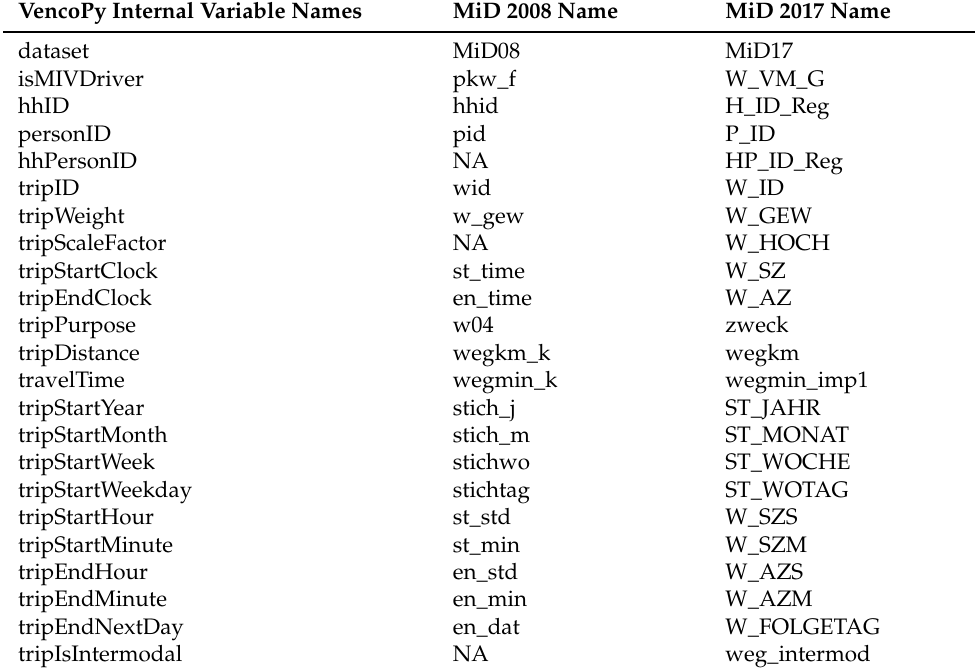
Table A1. Required trip variables from raw mobility travel surveys as a minimum requirement to serve as input to VencoPy. Shown are the VencoPy internal namings as well as the variable namings of the surveys MiD08 and MiD17 analyzed in the case